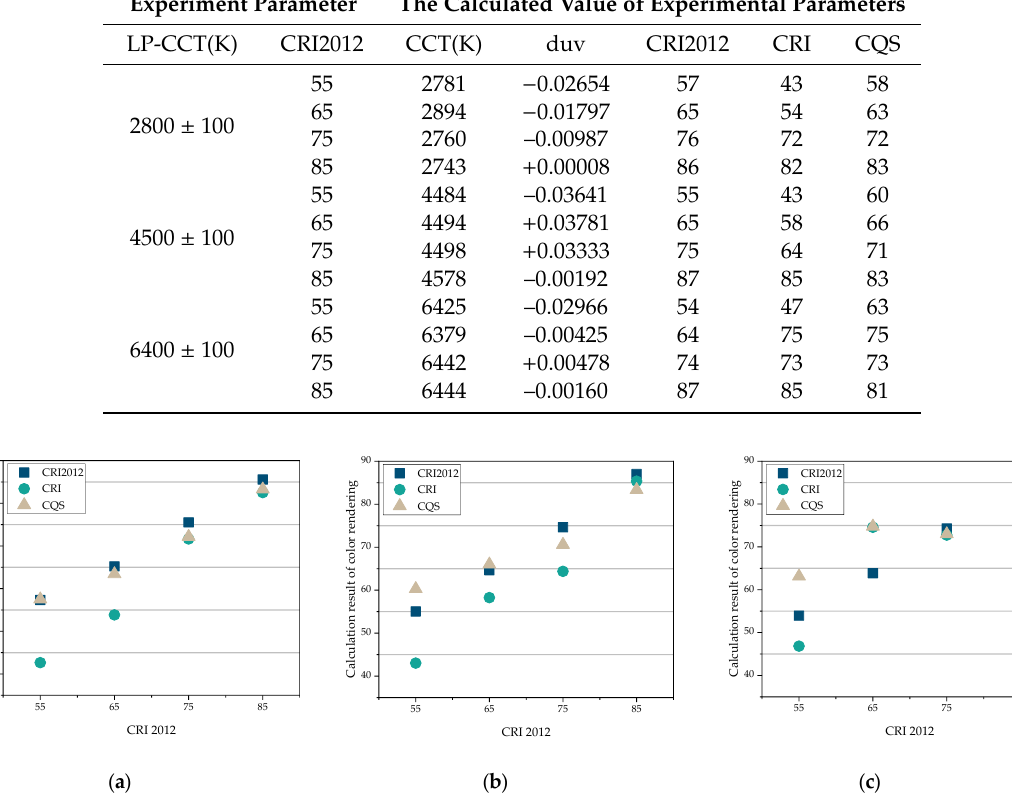
Figure 3. Comparison of three evaluation indexes of color rendering. ( a ) 2800 K. ( b ) 4500 K. ( c ) 6400 K.